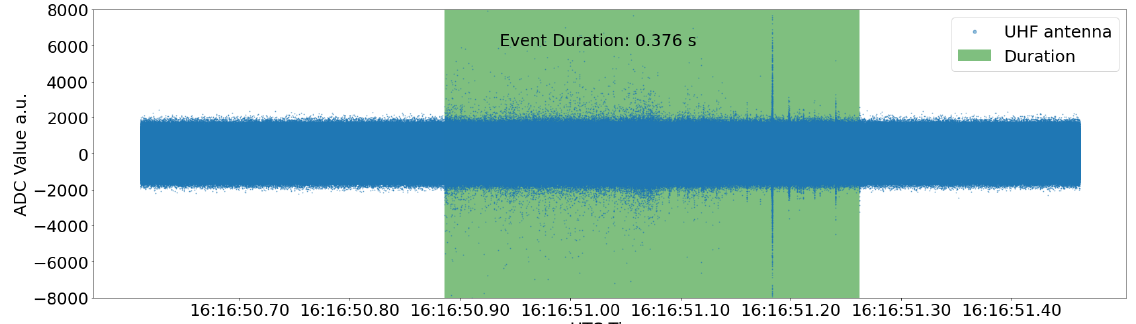
Figure 18. An example of lightning duration measurements based on radio signals captured by the UHF receiver. The length of the lightning duration is marked by the green overlay.